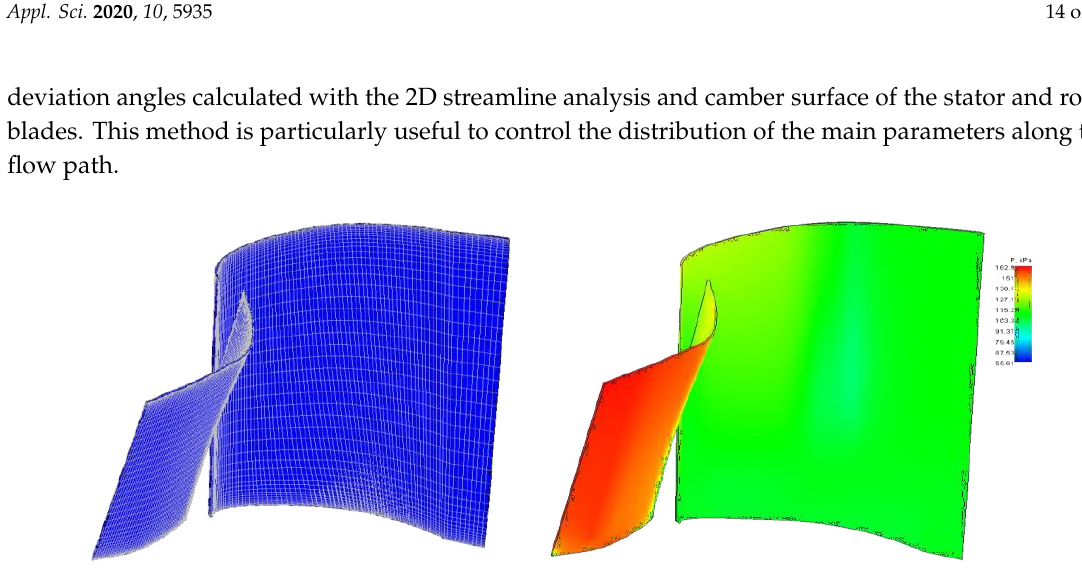
Figure 10. Axisymmetric CFD simulation mesh and results (pressure scene) view.